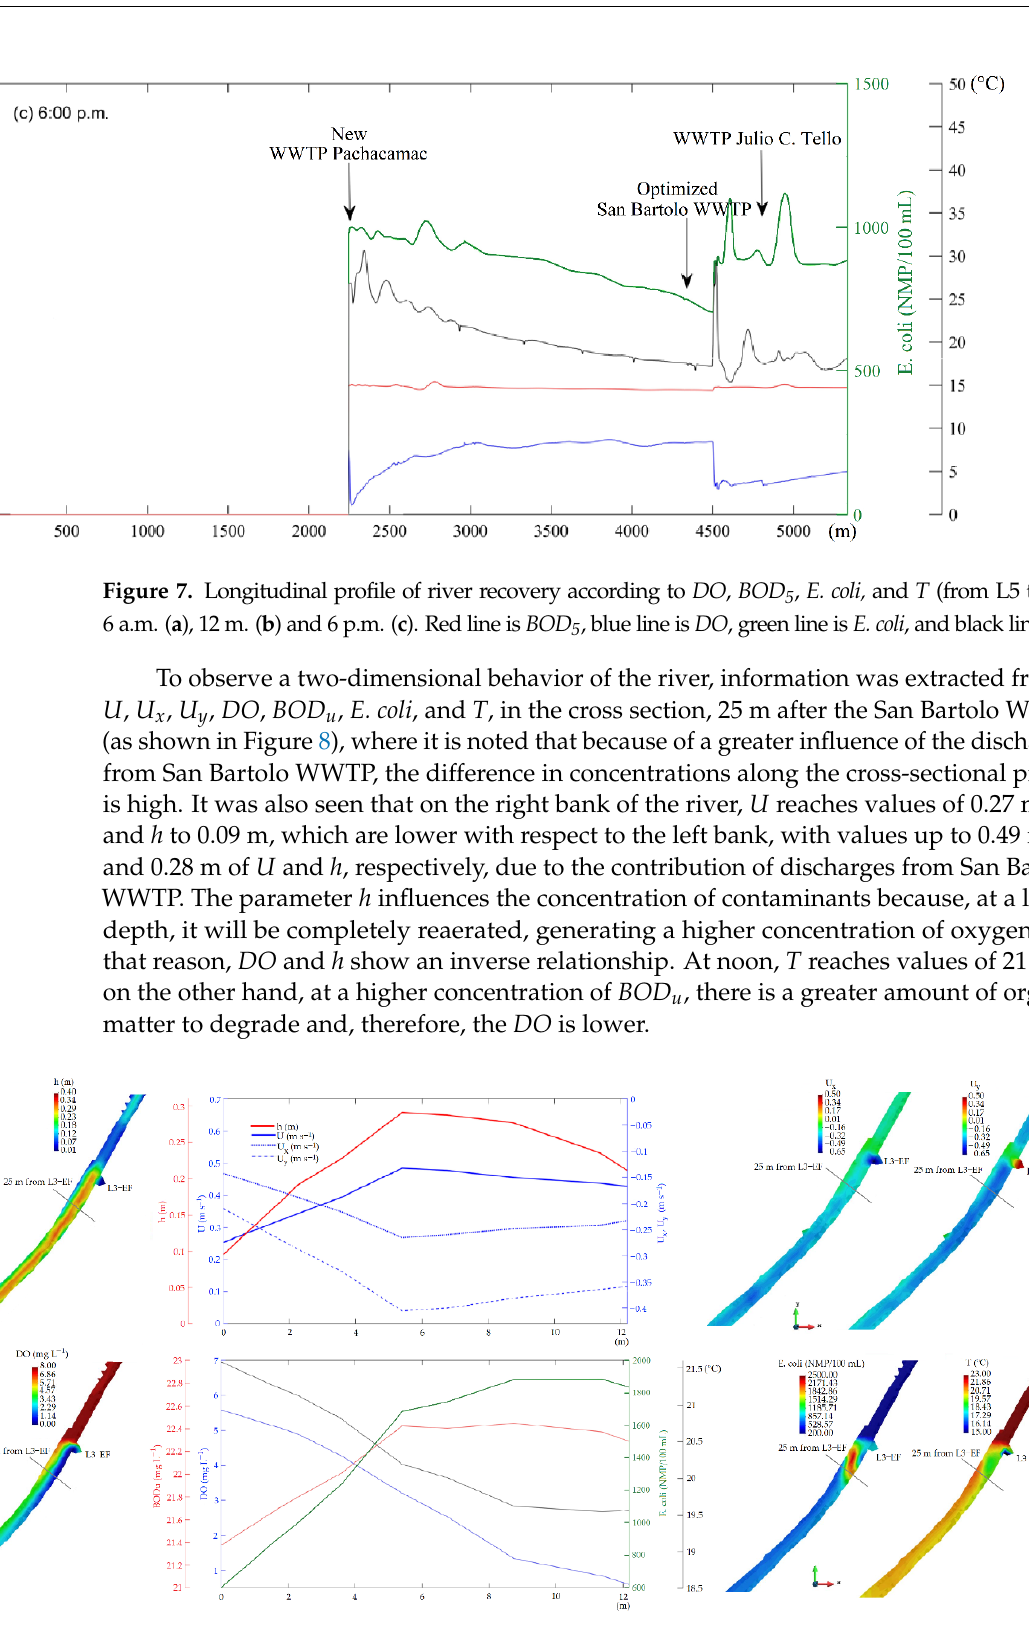
Figure 8. Cross-sectional profile of the recovery of the river according to DO , BOD u , E. coli , T , h , U , U x , and U y , downstream San Bartolo WWTP, at 12:00 m. Top panel: red line is h , blue line is U , dotted blue line is U x , dashed blue line is U y . Bottom panel: red line is BOD u , blue line is DO , green line is E. coli , black line is T.